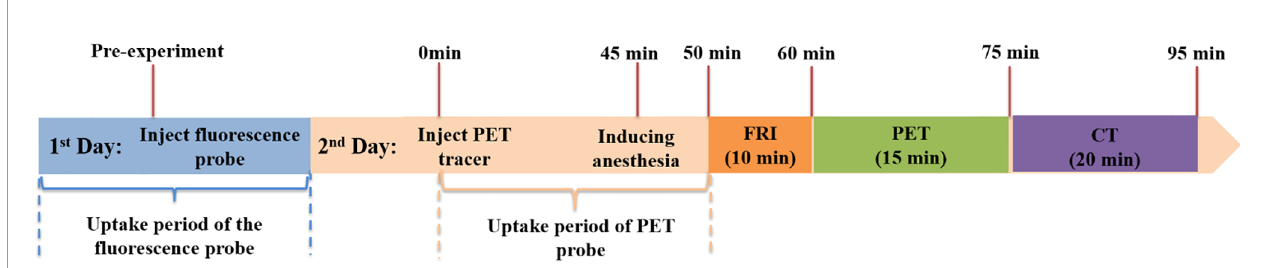
FIGURE 2 | Timeline of animal experiments. Thirty SPF grade BALB/c-nu/nu nude mice (6-8 weeks, weighing 18-22 g, male) were used for imaging and WB. Among them, half of them (15) were assigned to the control group and 15 to the experimental